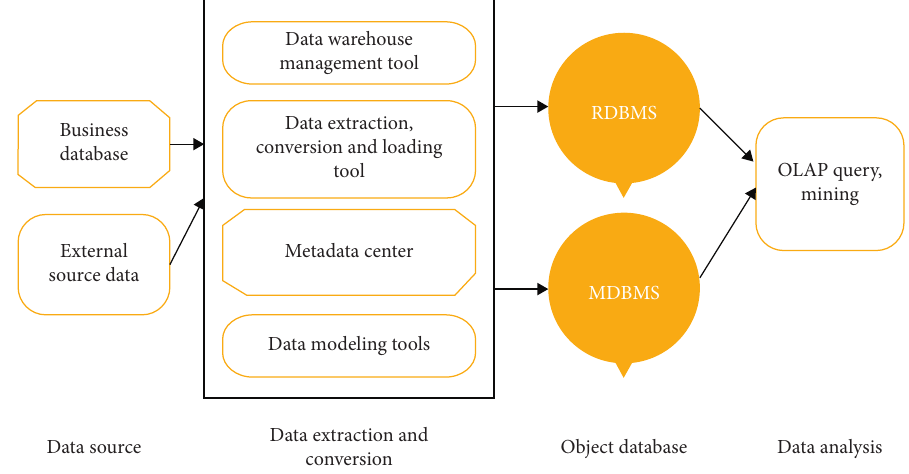
Figure 5: The overall structure of the data warehouse.